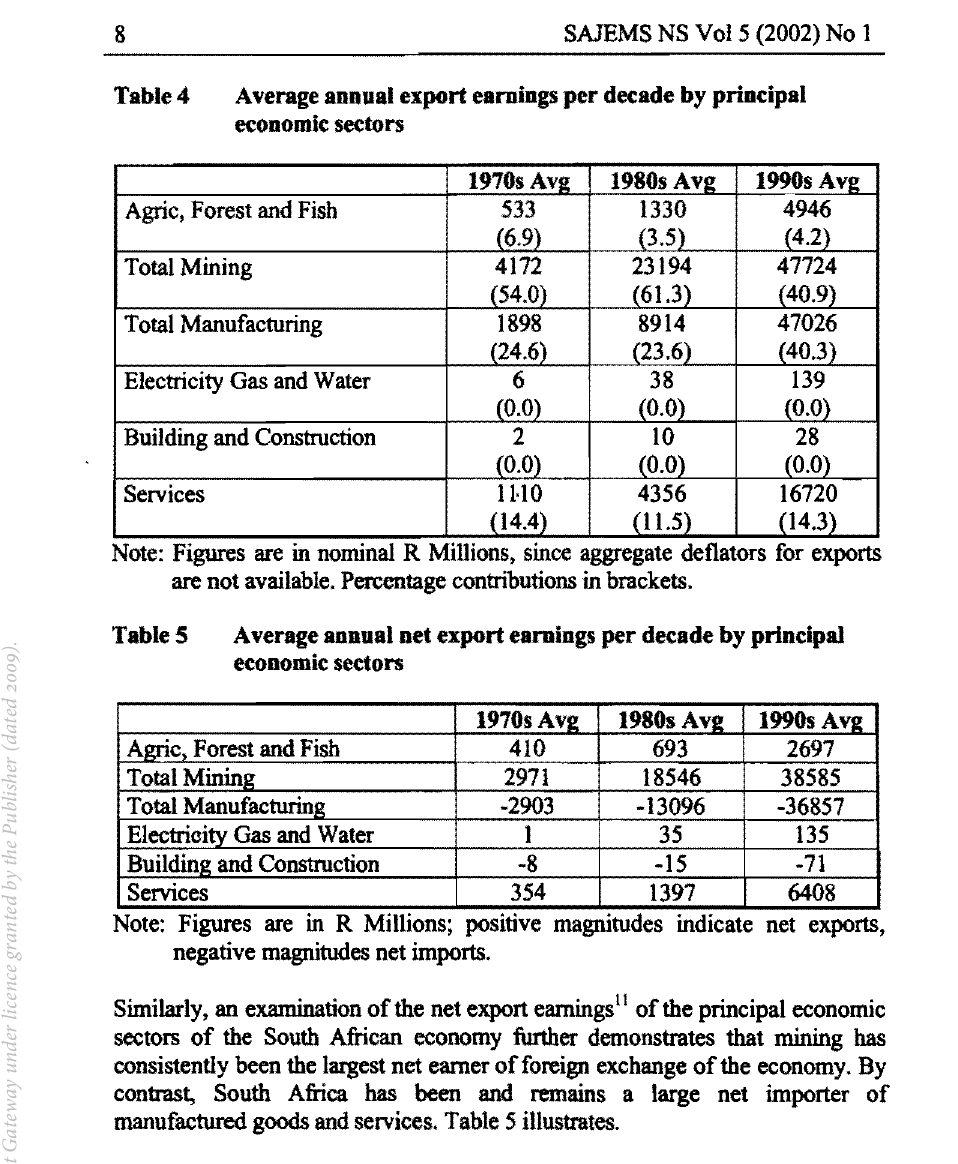
Average annual export earnings per decade by